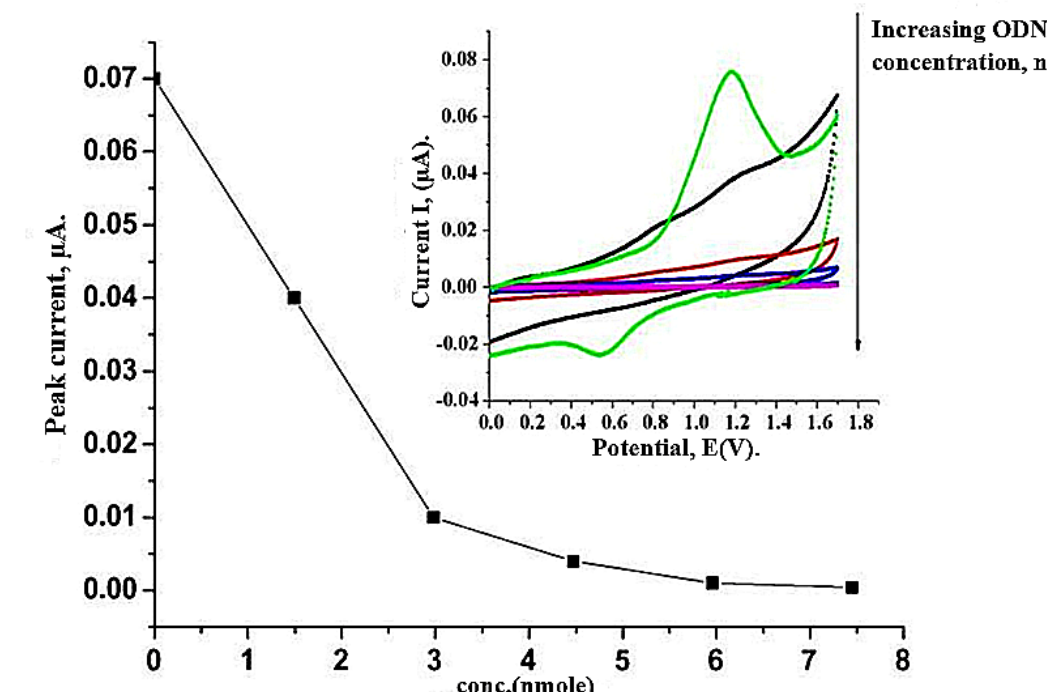
Figure 4. Variation of electrode current at constant potential E = 1.2 V, as a function of concentration of target ODN (inset: cyclic voltammograms of PHPT/ODN bioelectrode with increasing target ODN concentration, mmol) [49].